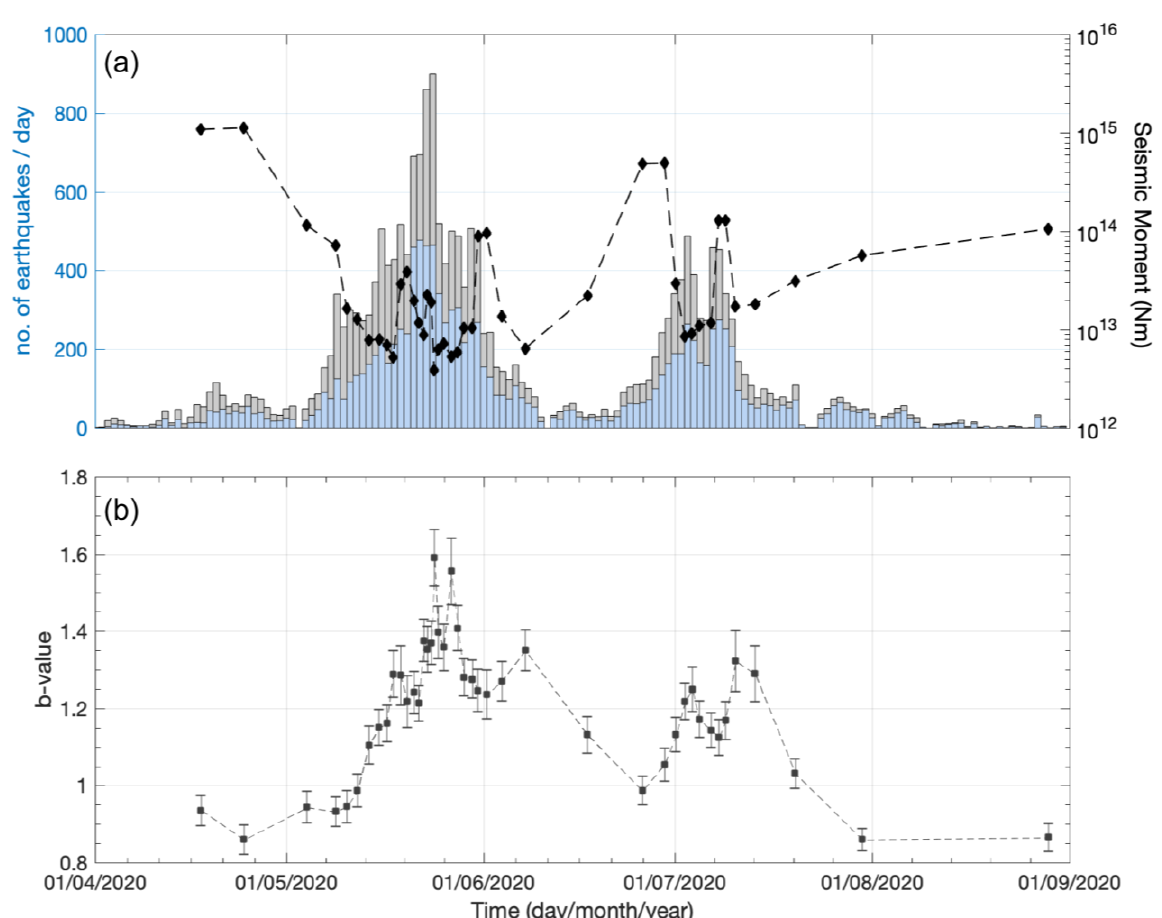
Figure 8. ( a ) Histogram of the number of events per day (gray) and the number of events with M ≥ 0.0 (blue) over time (left axis) for CAT2 1-3 . The black diamond symbols, linked by a dashed line, show the cumulative seismic moment release in each temporal window (right axis). ( b ) Temporal variations of the b -value (filled squares) and the associated error bars, as estimated from the G – R relation for CAT2 1 – 3 , in sliding windows of 1000 events with 50% overlap.